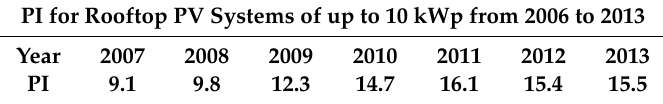
Table 10. The PI for rooftop PV systems of up to 10 kWp from 2006 to 2013. PI for Rooftop PV Systems of up to 10 kWp from 2006 to 2013